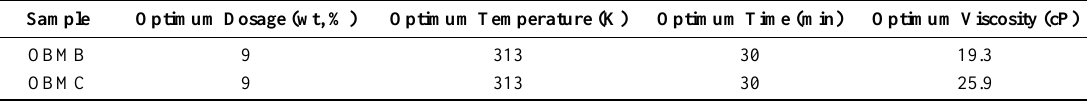
Table 8. Optimum Parameters